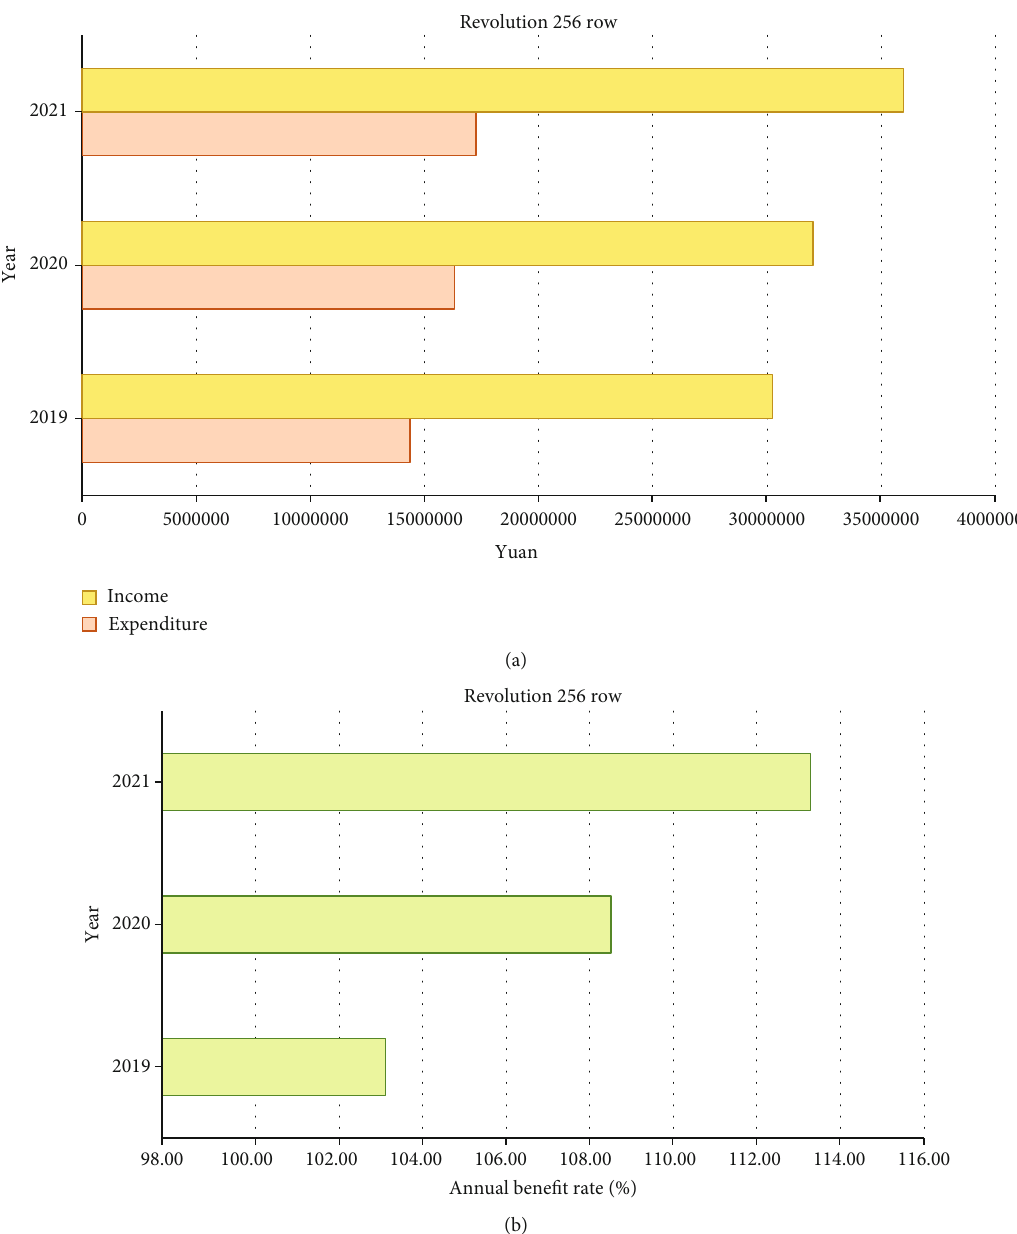
Figure 5: Analysis of operation cost of Revolution 256 row (256-row CT). (a) The annual income and expenditure of Revolution 256 row (256-row CT) from 2019 to 2021. (b) The annual bene fi t rate of Revolution 256 row (256-row CT) from 2019 to